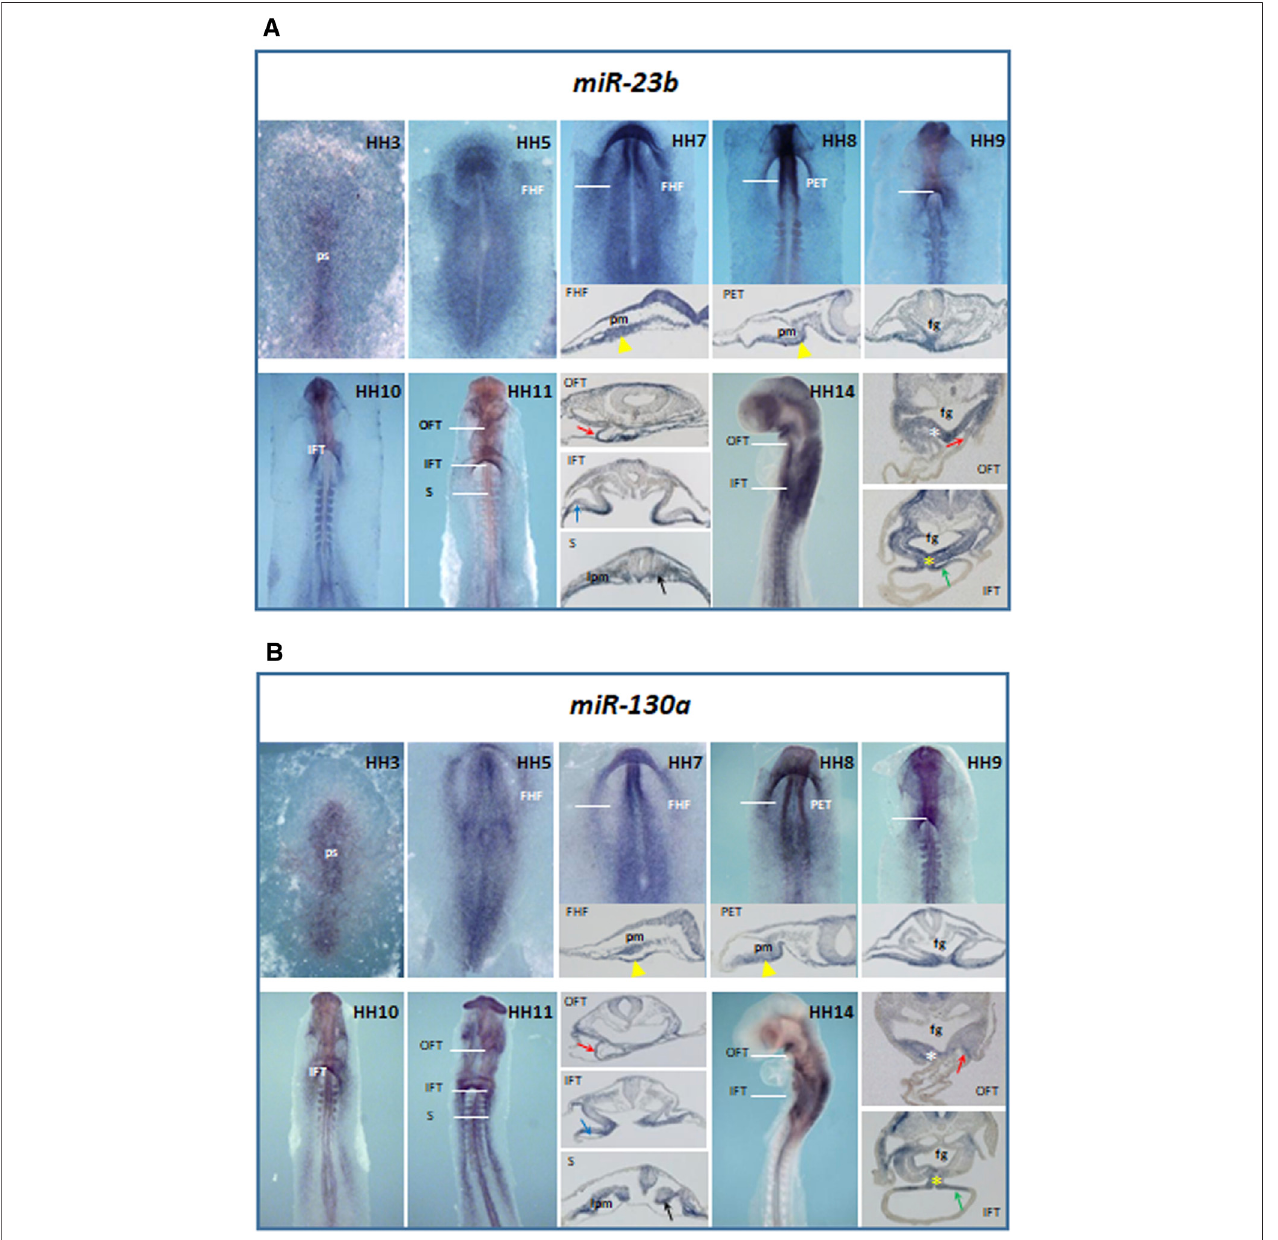
FIGURE 1 | Whole-mount ISH analysis of miR-23b (A) , miR-130a (B) , miR-106a (C) , and miR-100 (D) during chick embryo cardiac development, from HH3 throughHH14. Whitelinesindicatethetransversesectionlevelsofselectedembryos:FHF, fi rstheart fi eld;PET,primitiveendocardialtube;IFT,in fl owtract;OFT,out fl ow tractandS,somitelevel.Notetheirexpressionsintheprimitivestreak(ps),precardiacmesoderm(pm),adjacentendodermtoprecardiacmesoderm(yellowarrowhead), OFT (red arrow), dorsal surface of sinus venosus (green arrow), dorsal mesocardium (yellow asterisk), and vitelline vein (blue arrow); as well as in the foregut (fg), pharyngealmesoderm(whiteasterisk),lateralplatemesoderm(lpm),andsomites(blackarrow)formiR-23b (A) ,miR-130a (B) ,andmiR-106a (C) .JustfromstageHH15 is observable miR-100 expression (D) in cardiac structures. V,